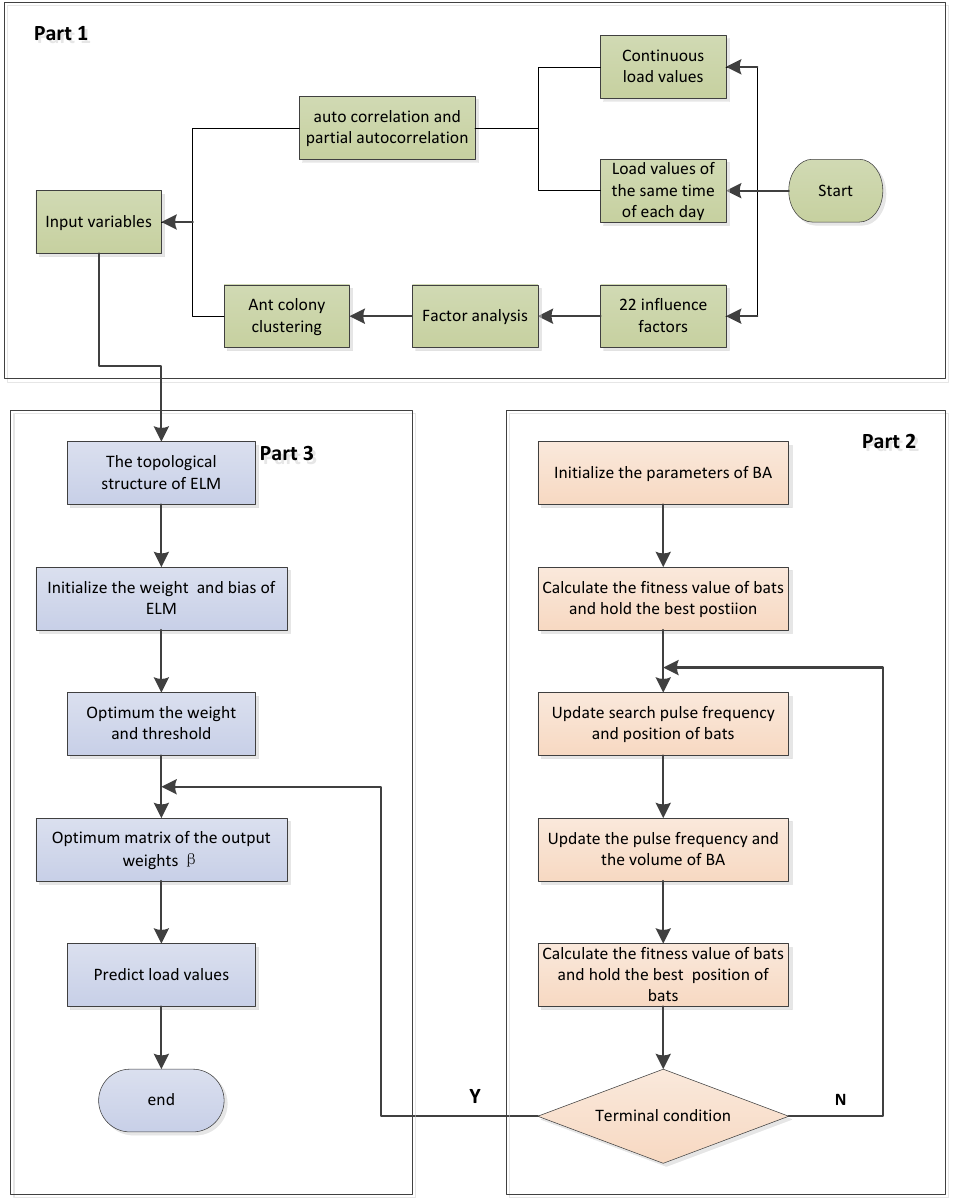
Figure 3. The flowchart of the factor analysis-ant colony clustering-bat algorithm-extreme learning machine (FA-ACC-BA-ELM) model.